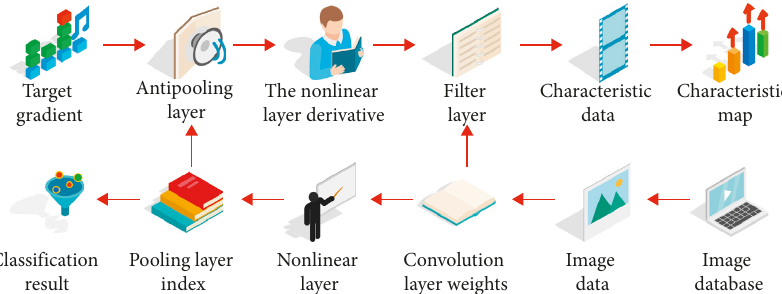
Figure 1: Music content feature visualization and model evaluation method of deep